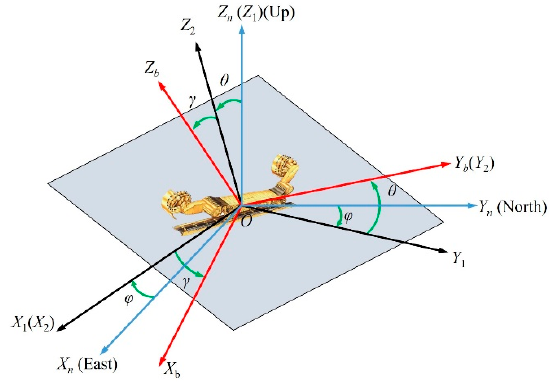
Figure 2. Orientation relationship between b system and n system.